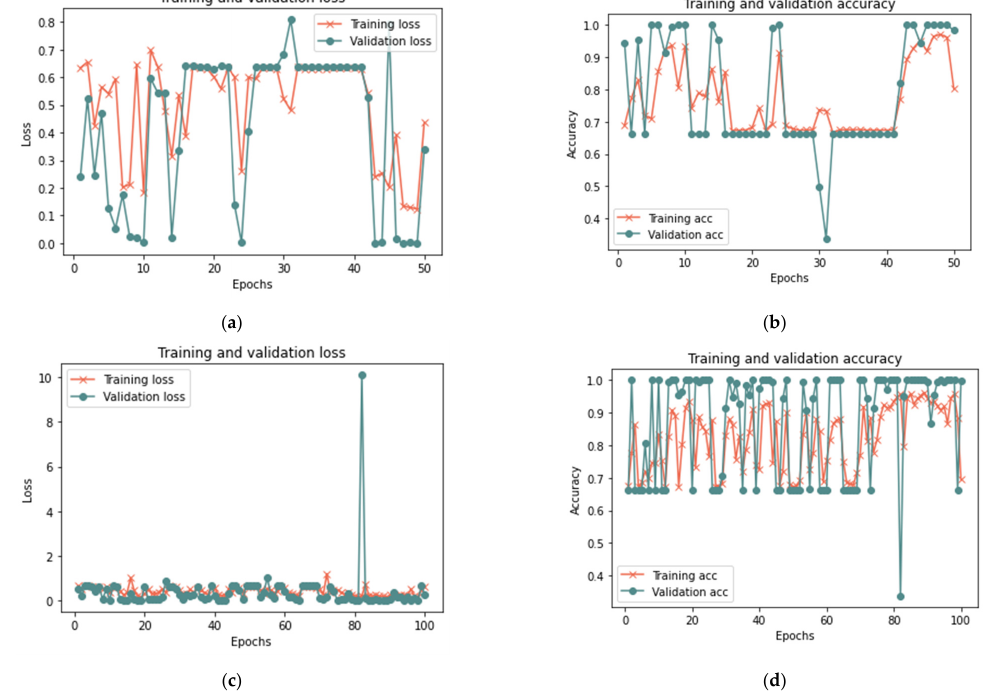
Figure 11. Results of the first scenario with 50% sample size: ( a ) loss at 50 iterations; ( b ) accuracy at 50 iterations; ( c ) loss at 100 iterations; and ( d ) accuracy at 100 iterations.